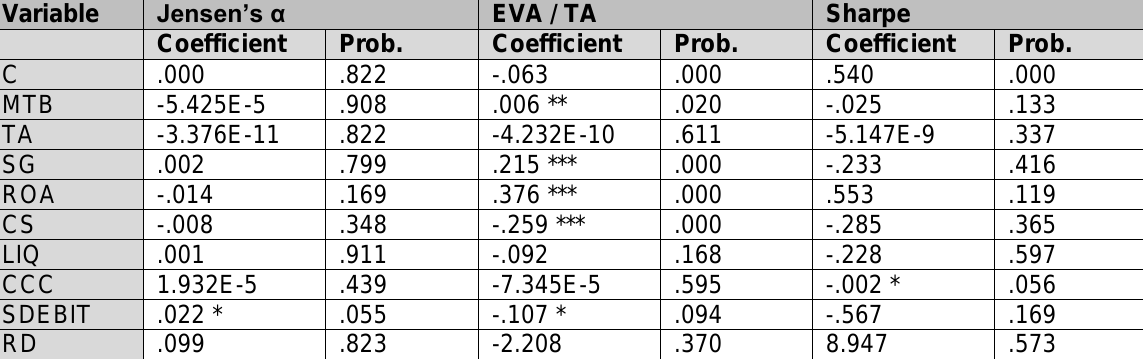
Table 3: Regression results of South African companies